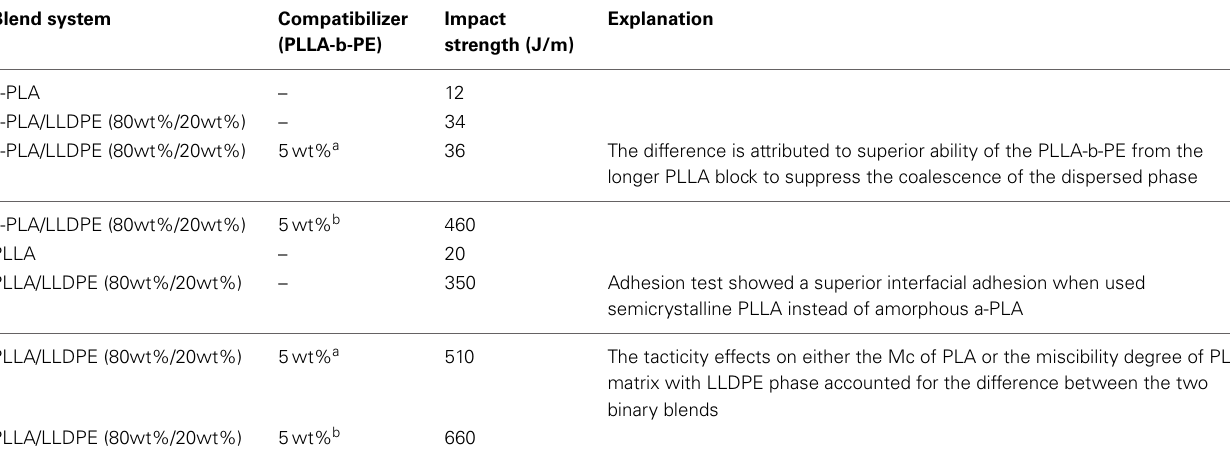
Table 9 | Results summary and explanation.